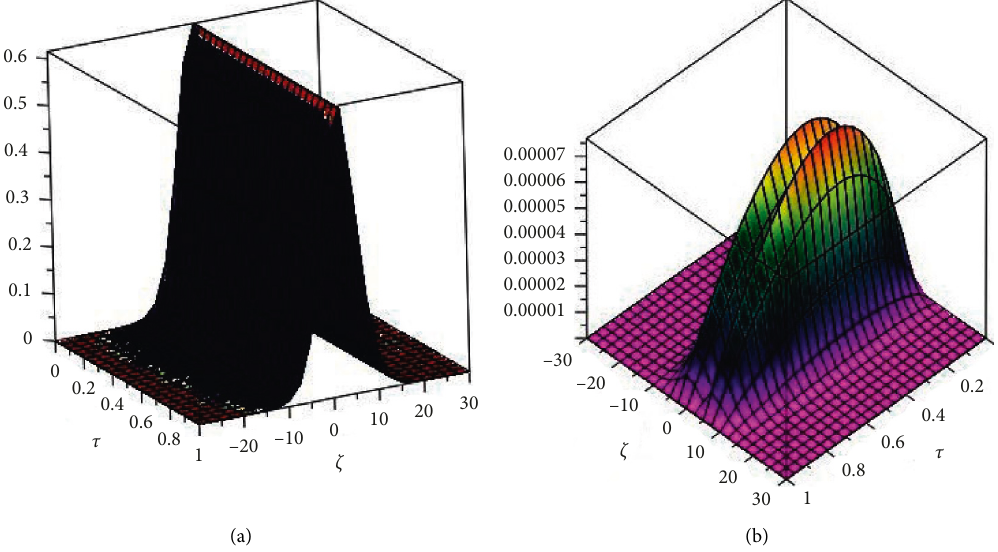
Figure 6: Figure of (a) at various fractional-order of β and (b) error graph of Example 3.